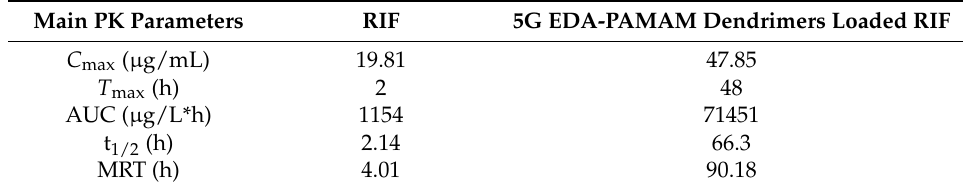
Figure 5. PEGylated 5G EDA-PAMAM dendrimers and RIF. Table 1. Pharmacokinetic (PK) profile of 5G EDA-PAMAM dendrimers loaded rifampicin (RIF) and RIF.